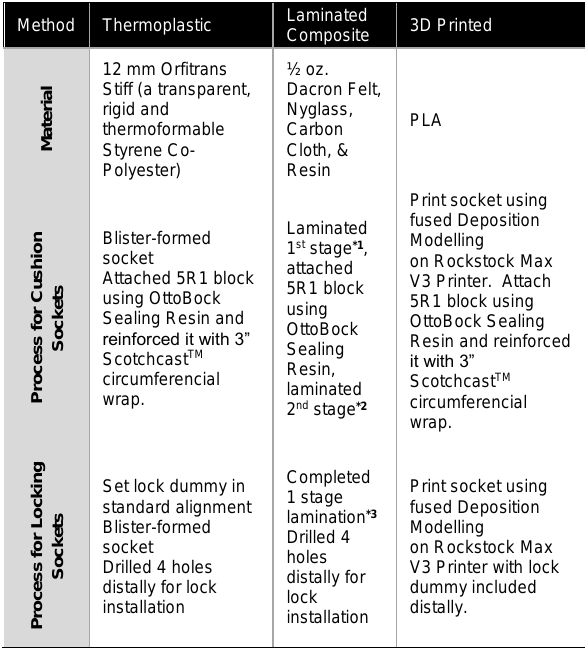
TABLE 1. Processes used to produce sockets. Every effort was